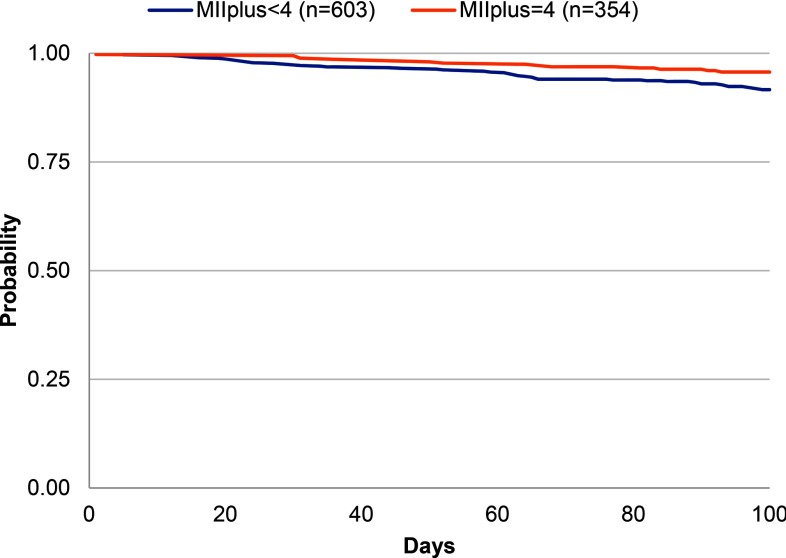
Kaplan-Meier Survival Curves of Contraceptive Continuation by MII With the Added Question About Method Switching (MIIplus) Among Pill Users at EnrollmentAbbreviation: MII, Method Information Index.